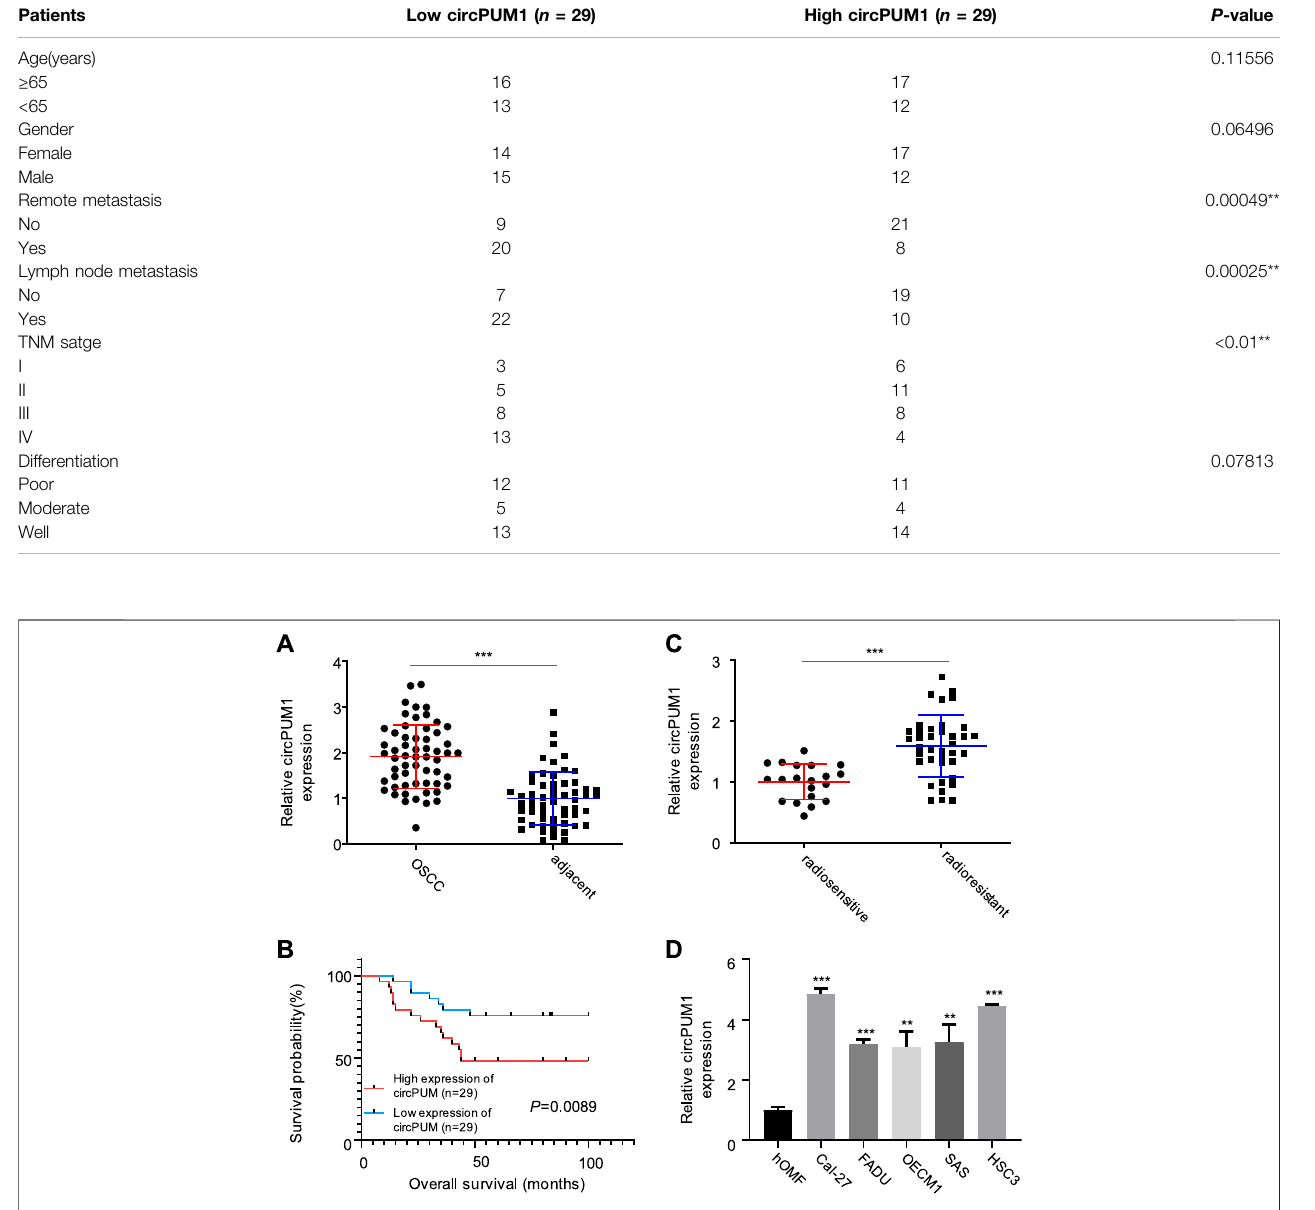
FIGURE 1 | Expression of CircPUM1 in OSCC carcinoma and adjacent tissues (A) ; overall survival rate of low-expression group and high-expression group of CircPUM1 (B) ; expression of CircPUM1 in OSCC tissues with different radiation doses (C) ; expression of CircPUM1 in different OSCC cells (D) . p < 0.01 ( pp ) and p < 0.001 ( ppp